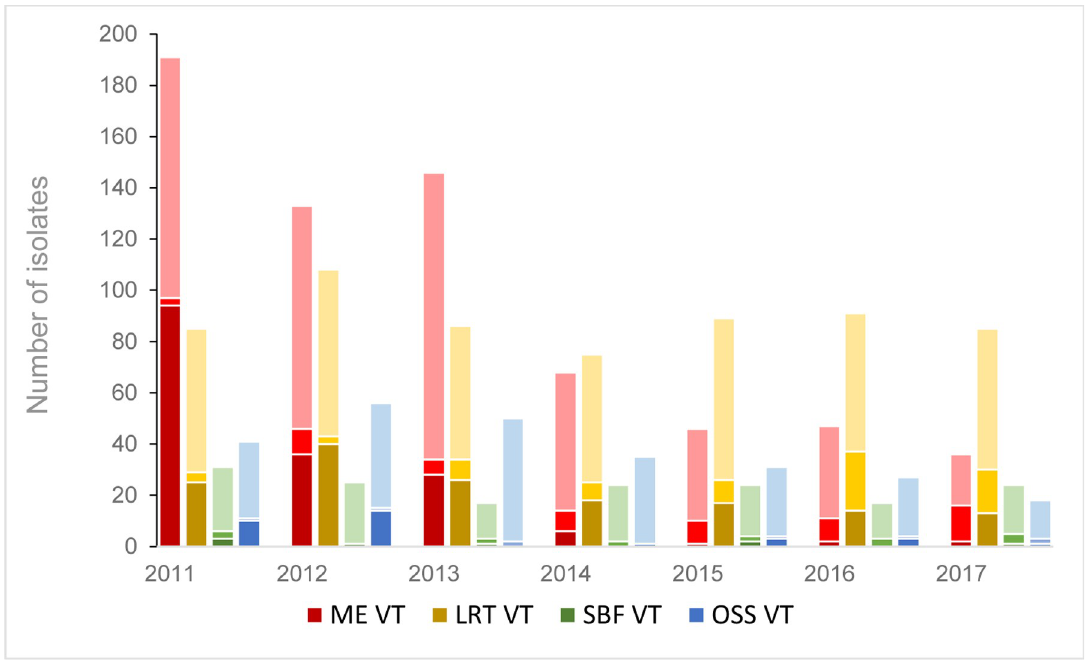
Fig 1. Annual numbers of PNSP of vaccine serotypes, PNSP of non-vaccine serotypes and susceptible pneumococcal isolates according to sampling site. In each cumulative column, the PNSP of VTs are shown in the darkest color at the bottom, the PNSP of NVTs in lighter color in the middle area and the PSP in the lightest color at the top of the columns. The colors differ to differentiate the sampling site presented, red for middle ear, yellow for lower respiratory tract, green for sterile body fluids and blue for other sampling